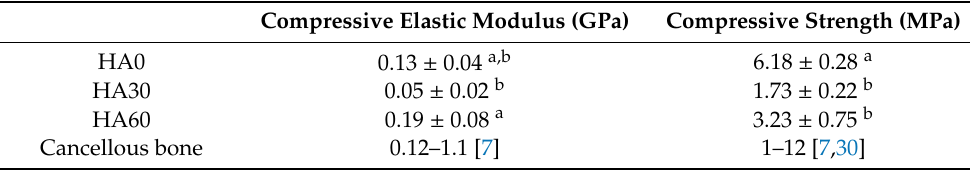
Table 5. Mechanical properties of the HA sca ff olds and human cancellous bone ( n =